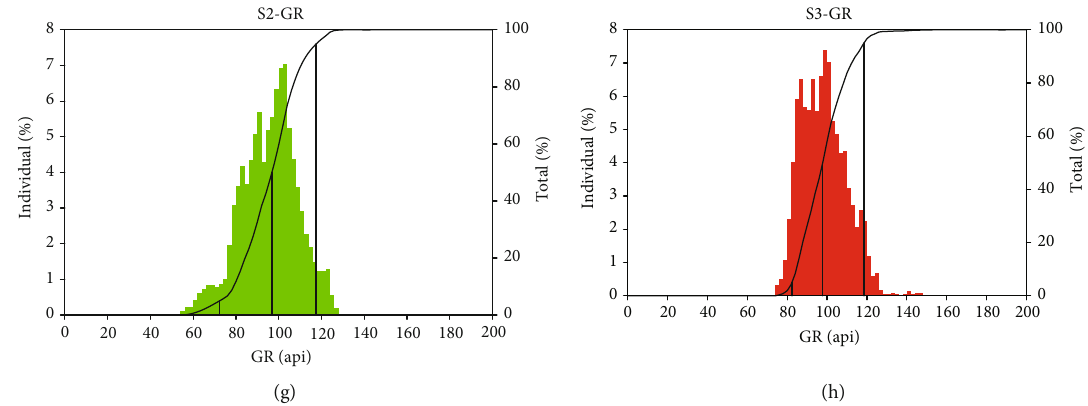
Figure 3: Histogram of porosity and GR frequency distribution in S Table 2: The three porosity and GR distribution ranges of S